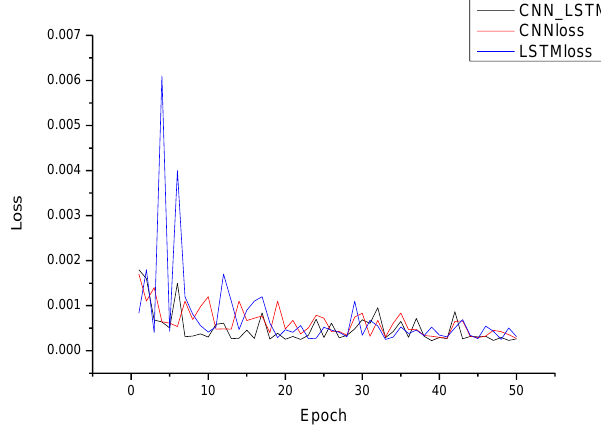
Figure 13. Loss diagram of each model for the test set.